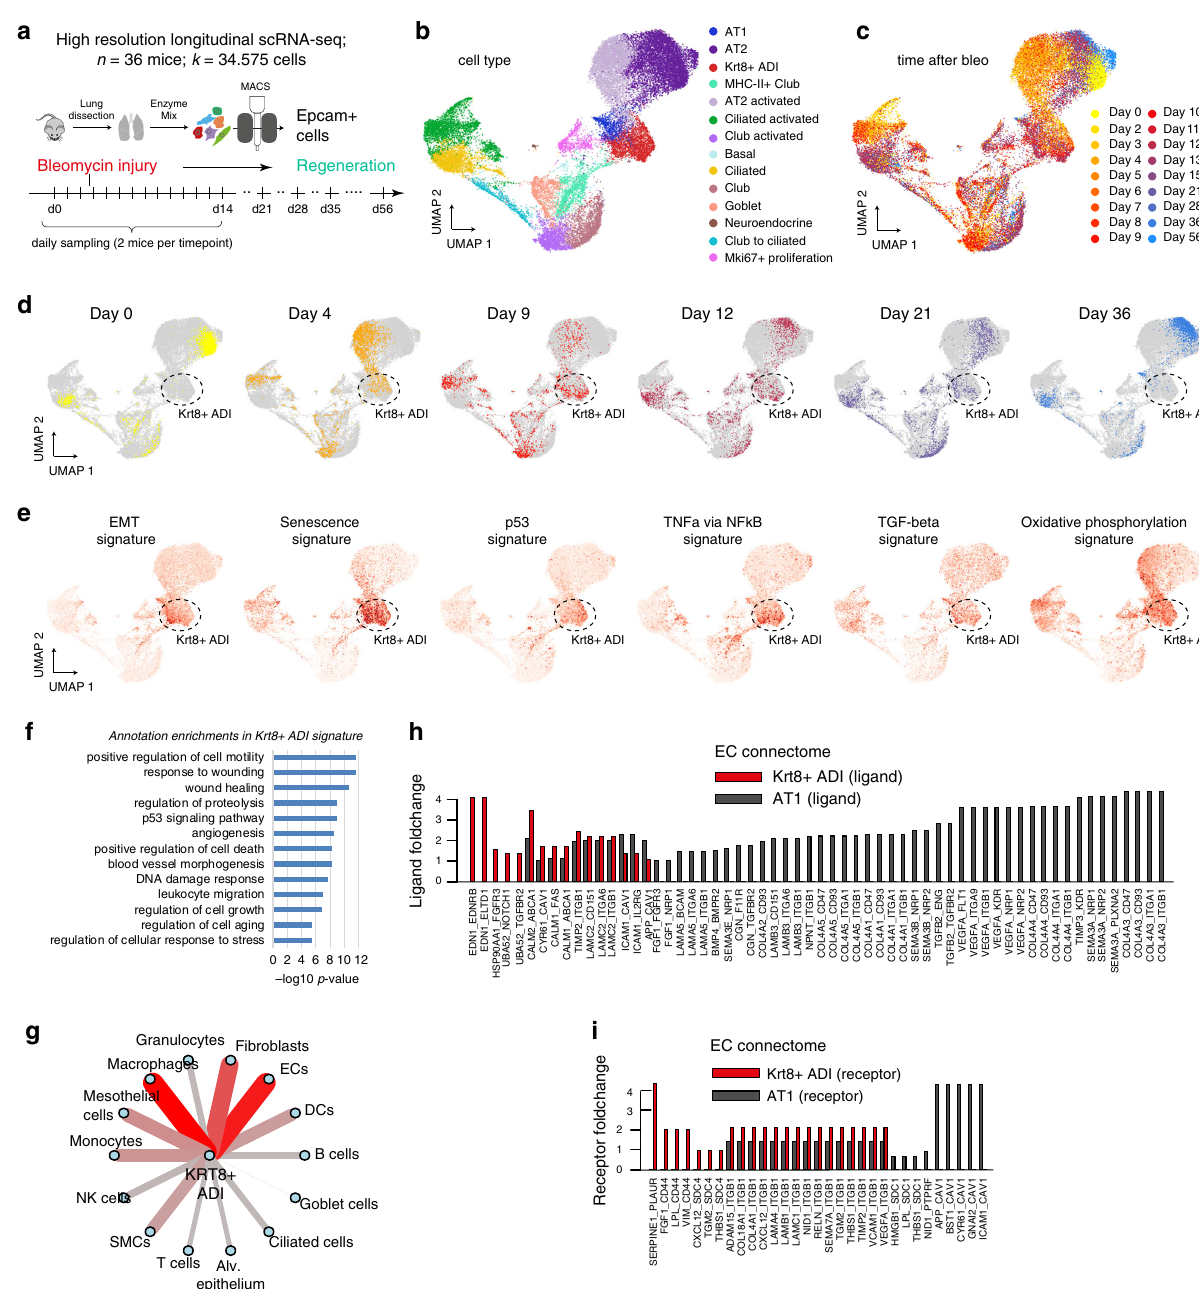
Fig. 4 Krt8+ADI cells feature unique pathway and cell – cell communication activities. a A high-resolution longitudinal data set was generated by subjecting sorted cells from the epithelial compartment to scRNAseq at the 18 indicated time points. UMAP embedding displays cells colored by ( b ) cell type identity and ( c ) time point. d The colored dots on the UMAP illustrate densities and distribution of cells at individual time points after bleomycin injury. Note the time dependent movement of cells within the data manifold. e UMAP embedded visualizations of single cells colored by gene expression signature scores for the indicated pathways (MSigDB Hallmark gene sets). f The indicated terms were signi fi cantly enriched in the Krt8 + ADI signature compared to all other epithelial cell states. g The cell – cell communication network displays the number of receptor-ligand pairs between the molecular markers of the Krt8 + ADI state and all other meta cell type identities (Fig. 1). h , i The bar graphs show the average log2 fold change of either ( h ) receptors or ( i ) ligands within the endothelial cell (EC) connectome for Krt8 + ADI and AT1 Transcriptional convergence of alveolar and airway stem cells . RNA velocity vectors overlaid onto the UMAP embedding predicted transdifferentiation of club cells towards ciliated and